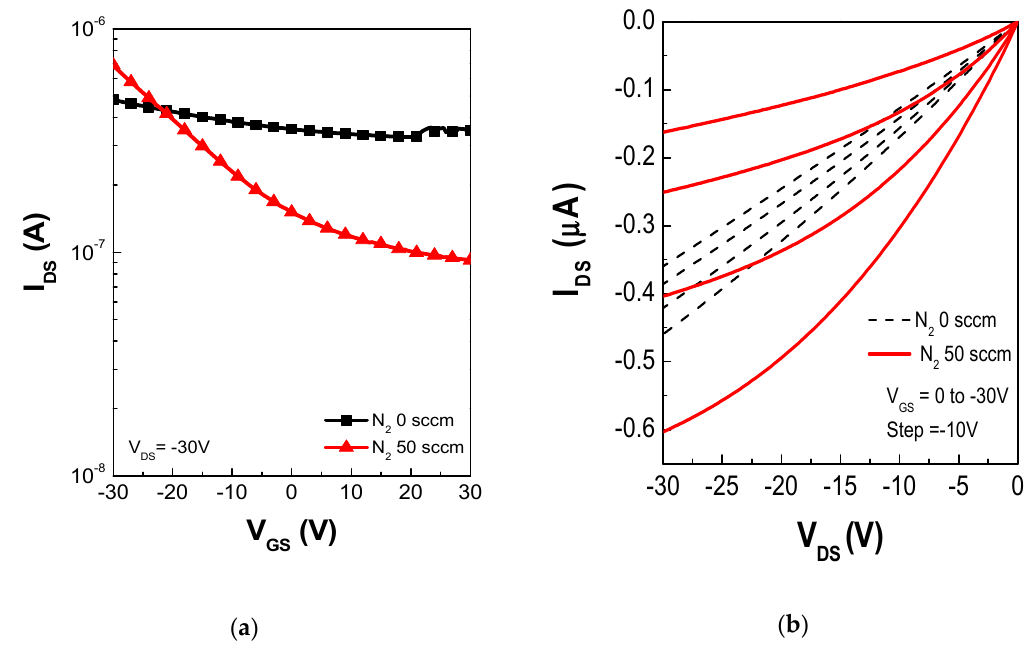
Figure 6. ( a ) Characteristics of Cu x O and thin-film transistors (TFTs) transfer curve according to N 2 flow rates. ( b ) Output curves of the Cu x O and CuON TFTs.